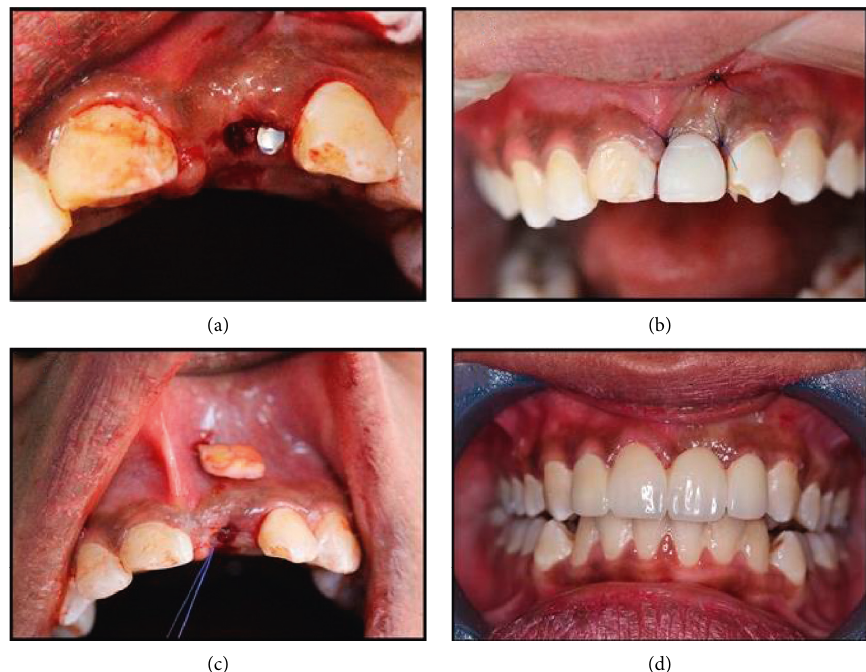
Figure 3: Clinical photographs showing modified pouch technique in test group. (a) Sibert class I ridge defect in the site of missing upper left central incisor, (b) modified pouch with the vertical incision beyond the mucogingival junction, (c) insertion of the connective tissue graft into the pouch from the vertical incision using positioning suture, and (d) final bridge was delivered after 6